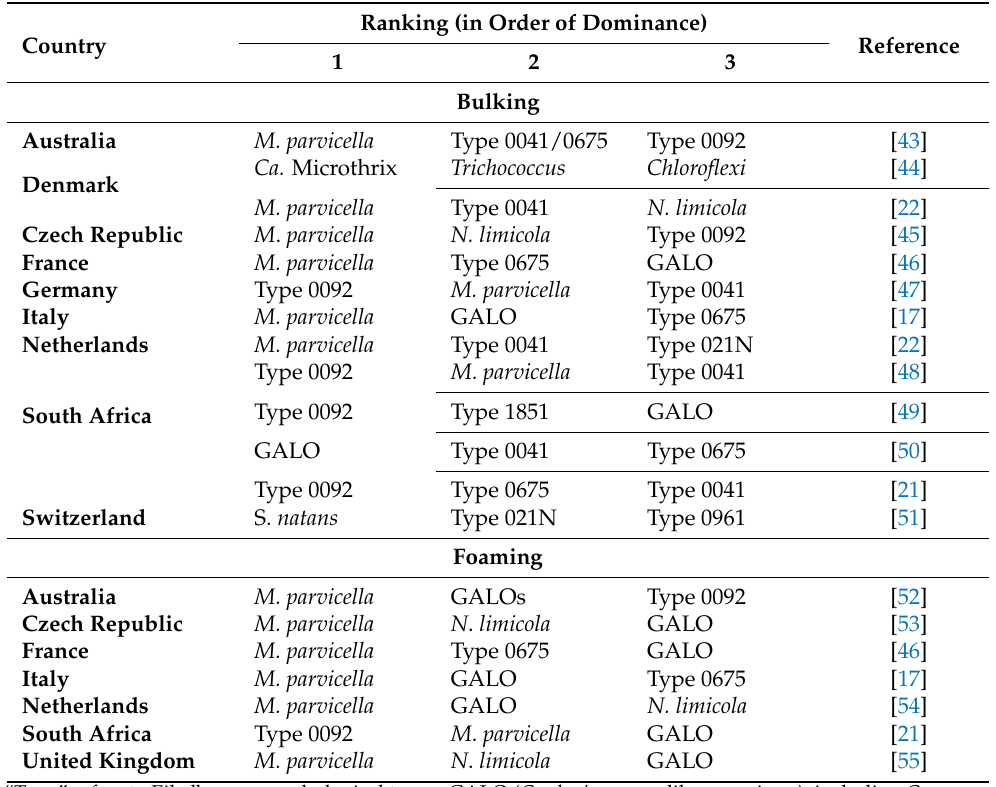
Table 1. Dominant filamentous bacteria in activated sludge wastewater treatment plants in different